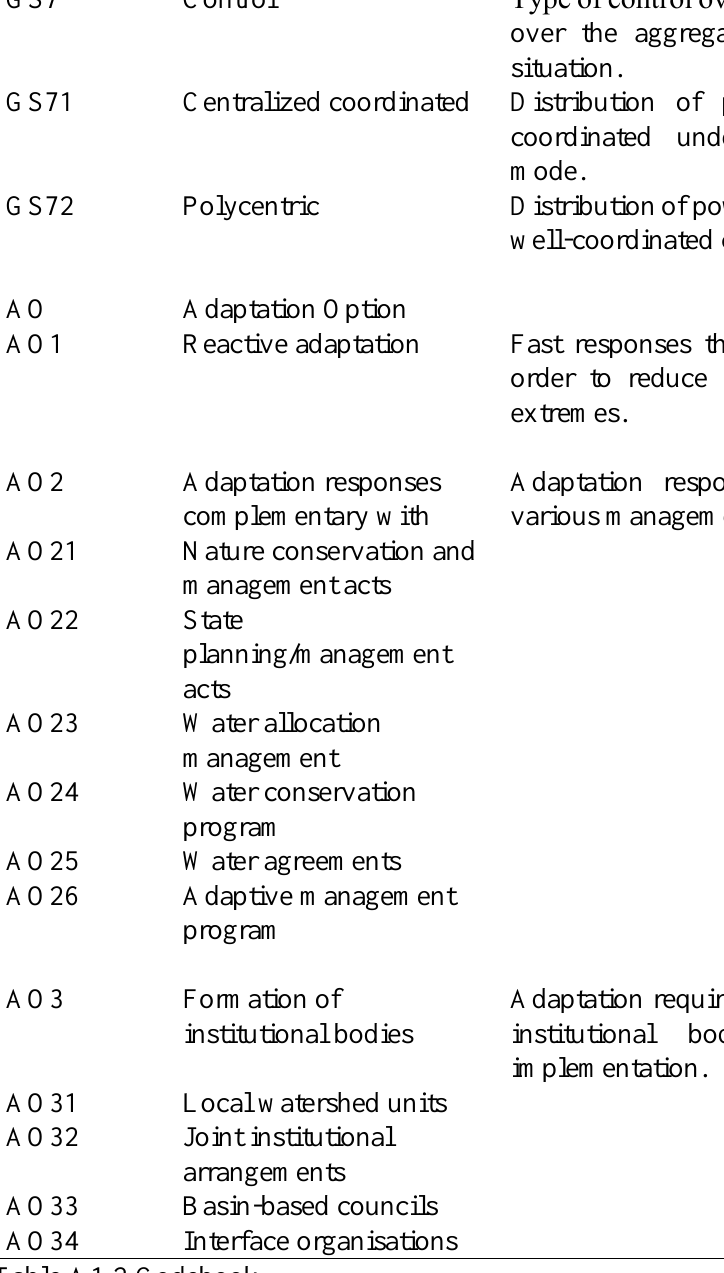
Table A1.2 Codebook DATA PROCESSING: ARCHETYPE ANALYSIS USING